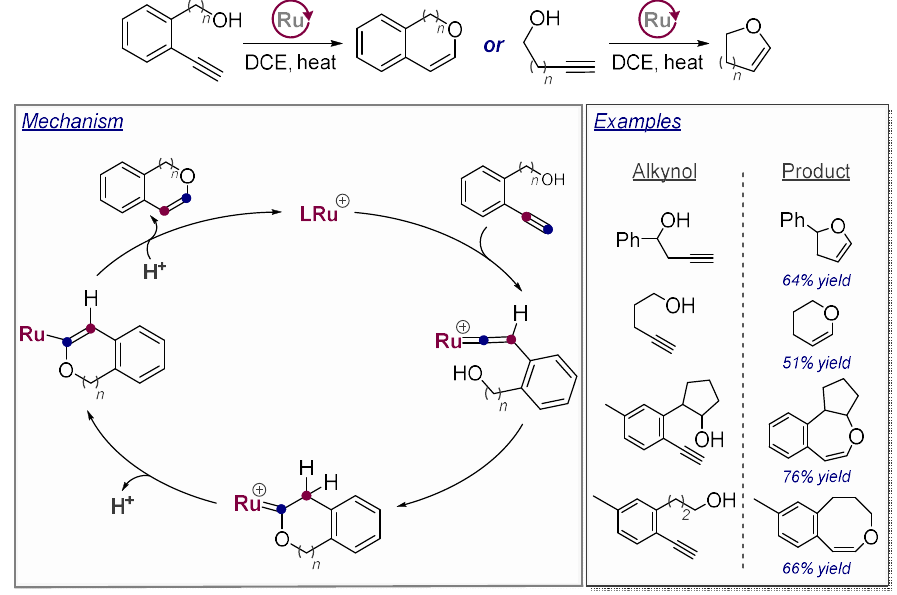
Scheme 24. Cycloisomerizations of terminal alkynols under Ru-catalysis.